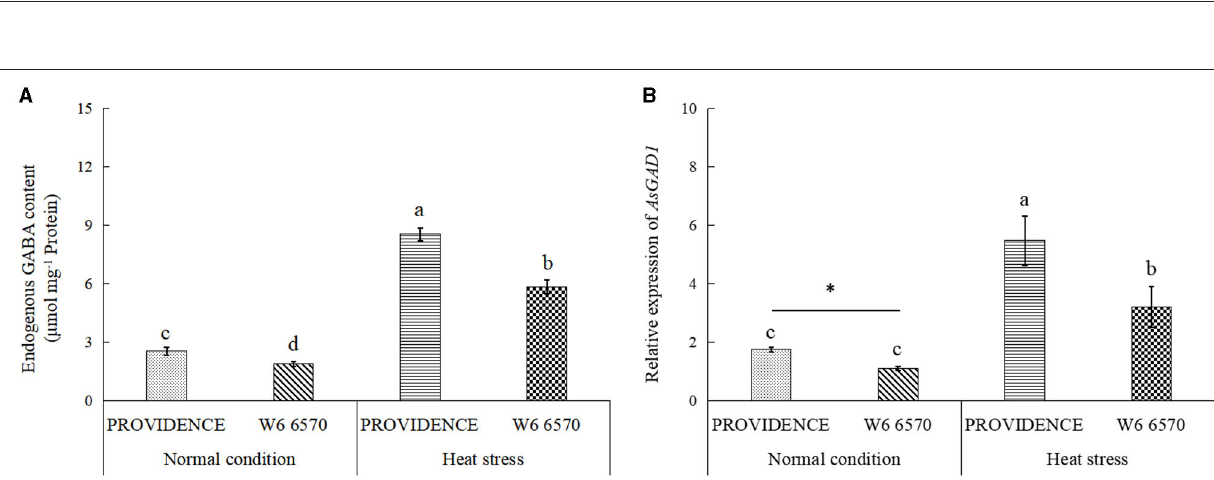
FIGURE 6 | Changes in (A) endogenous γ -aminobutyric acid (GABA) content and (B) relative expression of AsGAD1 gene in the leaves of two creeping bentgrass materials (PROVIDENCE and W6 6570) in response to 15 days of heat stress (38/33 ◦ C, day/night) in controlled growth chambers. Vertical bars indicate ± SE of mean ( n = 4), and different letters above column indicate significant differences ( P ≤